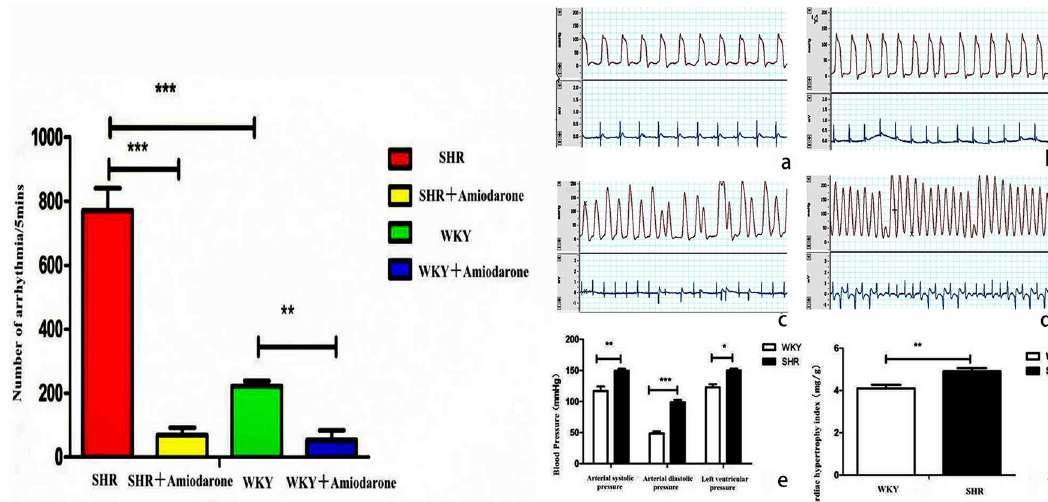
Figure 2. The effect of amiodarone on the animals in vivo. ( a ) Left ventricular pressure and electrocardiogram before aortic ligation in WKY group. ( b ) Left ventricular pressure and electrocardiogram before aortic ligation in SHR group. ( c ) Left ventricular pressure and electrocardiogram after aortic ligation in WKY group. ( d ) Left ventricular pressure and electrocardiogram after aortic ligation in SHR group. ( e ) Comparison of arterial pressure and left ventricular pressure between SHR and WKY rats. ( f ) Comparison of cardiac hypertrophy index between SHR and WKY rats.The total number of acute arrhythmias occurred within 5 min after coarctation of aortic arch for rapidly ascending hypertension (*representing P < 0.05, * * stands for P < 0.01, * * * represents P <